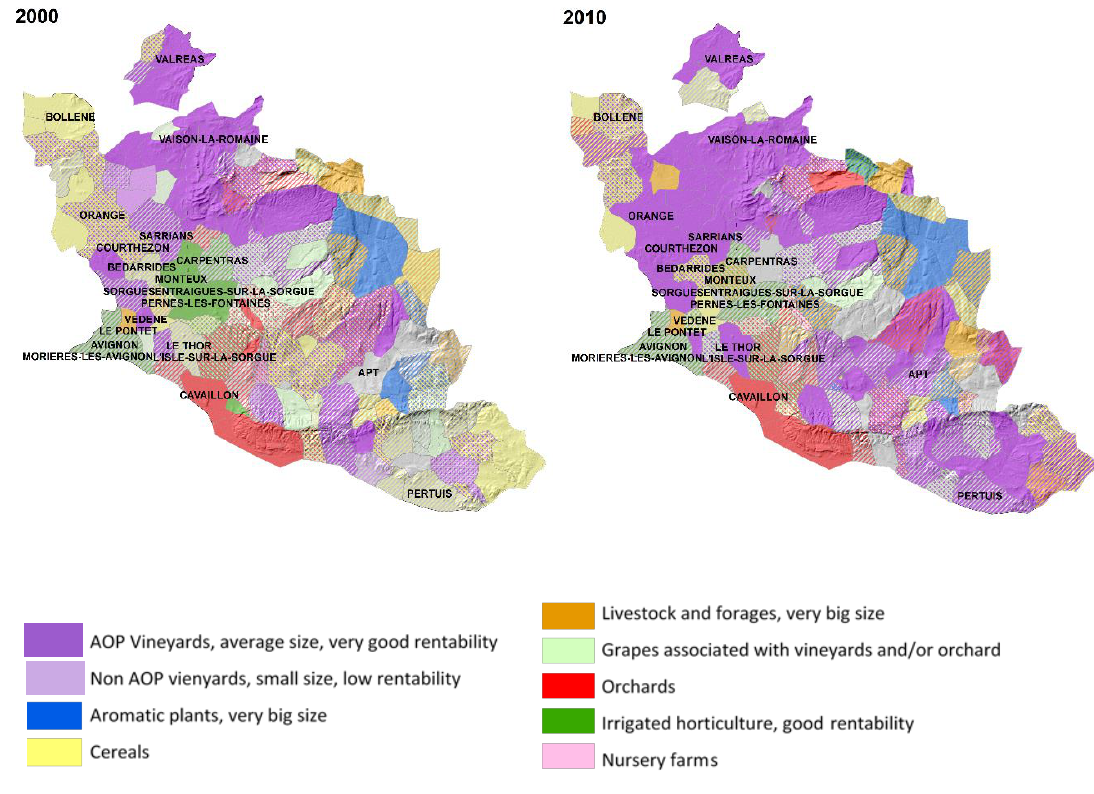
Figure 4. Farming systems’ maps from 2000 and 2010. Municipalities with full color are those with only a prevalent farming system. Municipalities with linear hatching are those where two farming systems co-exist and, finally, municipalities with square cross-hatching are those where three or more farming systems co-exist.